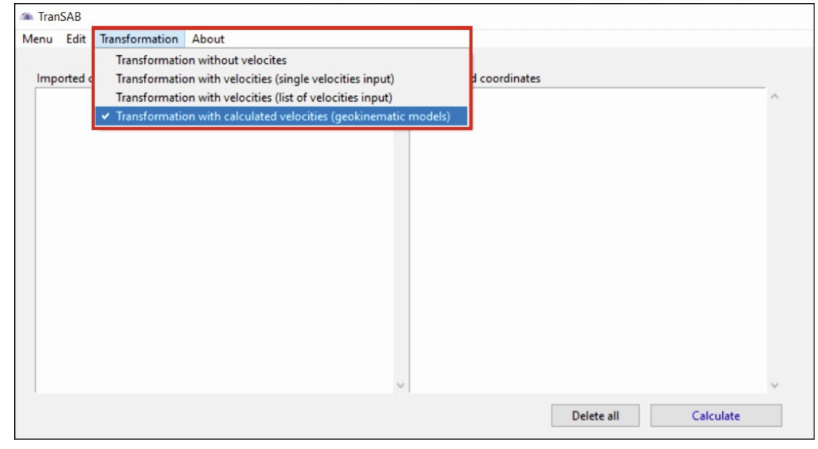
Figure 4. Transformation types.